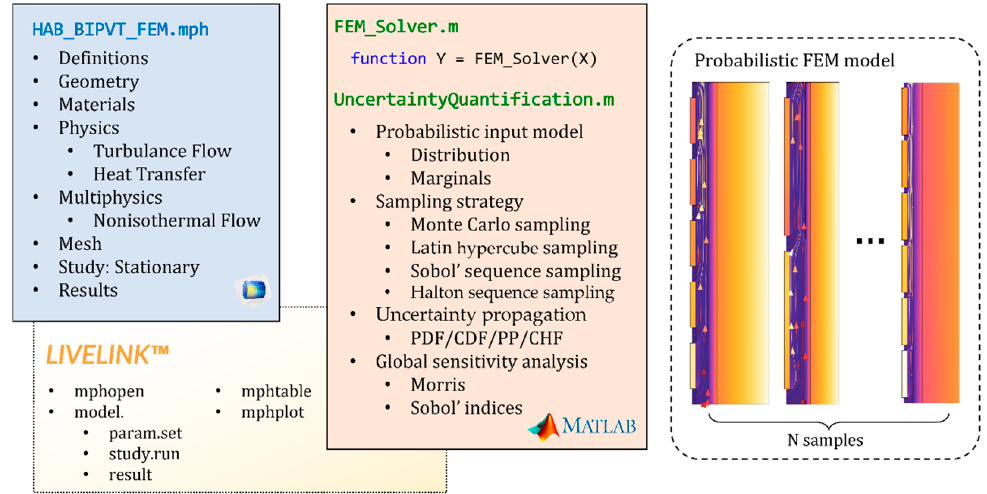
Figure 3. Implementation of uncertainty quantification in FEM program.